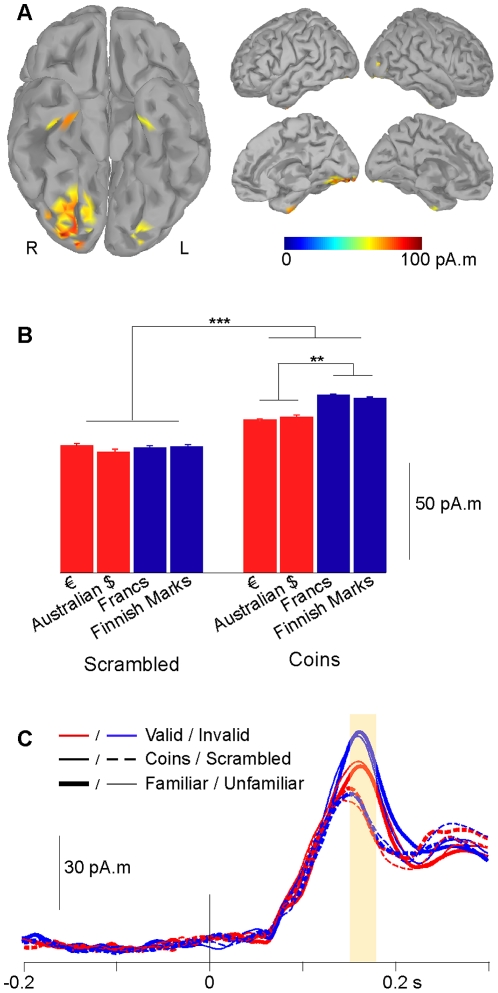
Estimated neural sources of the mean 150–175 ms activity.
A. The 60% top-most responsive regions (yellow/red scale) are all located in the ventral visual pathway, in the posterior part of the right fusiform and lingual gyri. R: right, L: left. B. Mean 150–175 ms activity in the right posterior fusiform and lingual region, in response to scrambled controls (left) and coins (right), valid (red) or invalid (blue). Responses to controls are smaller than to coins, and responses to valid coins are smaller than responses to invalid coins. ***: p<0.001; **: p<0.01 C. Time-courses of neural responses in the posterior fusiform and lingual region. In this region the dissociation between coins (solid lines) and scrambled controls (dotted lines) is quickly followed by a dissociation between valid (red solid lines) and invalid (blue solid lines) coins, corresponding to the significant interaction between Object Type and Validity. Familiarity with the coins does not affect the responses (thin vs. thick lines). The yellow box indicates the 150–175 ms time range.